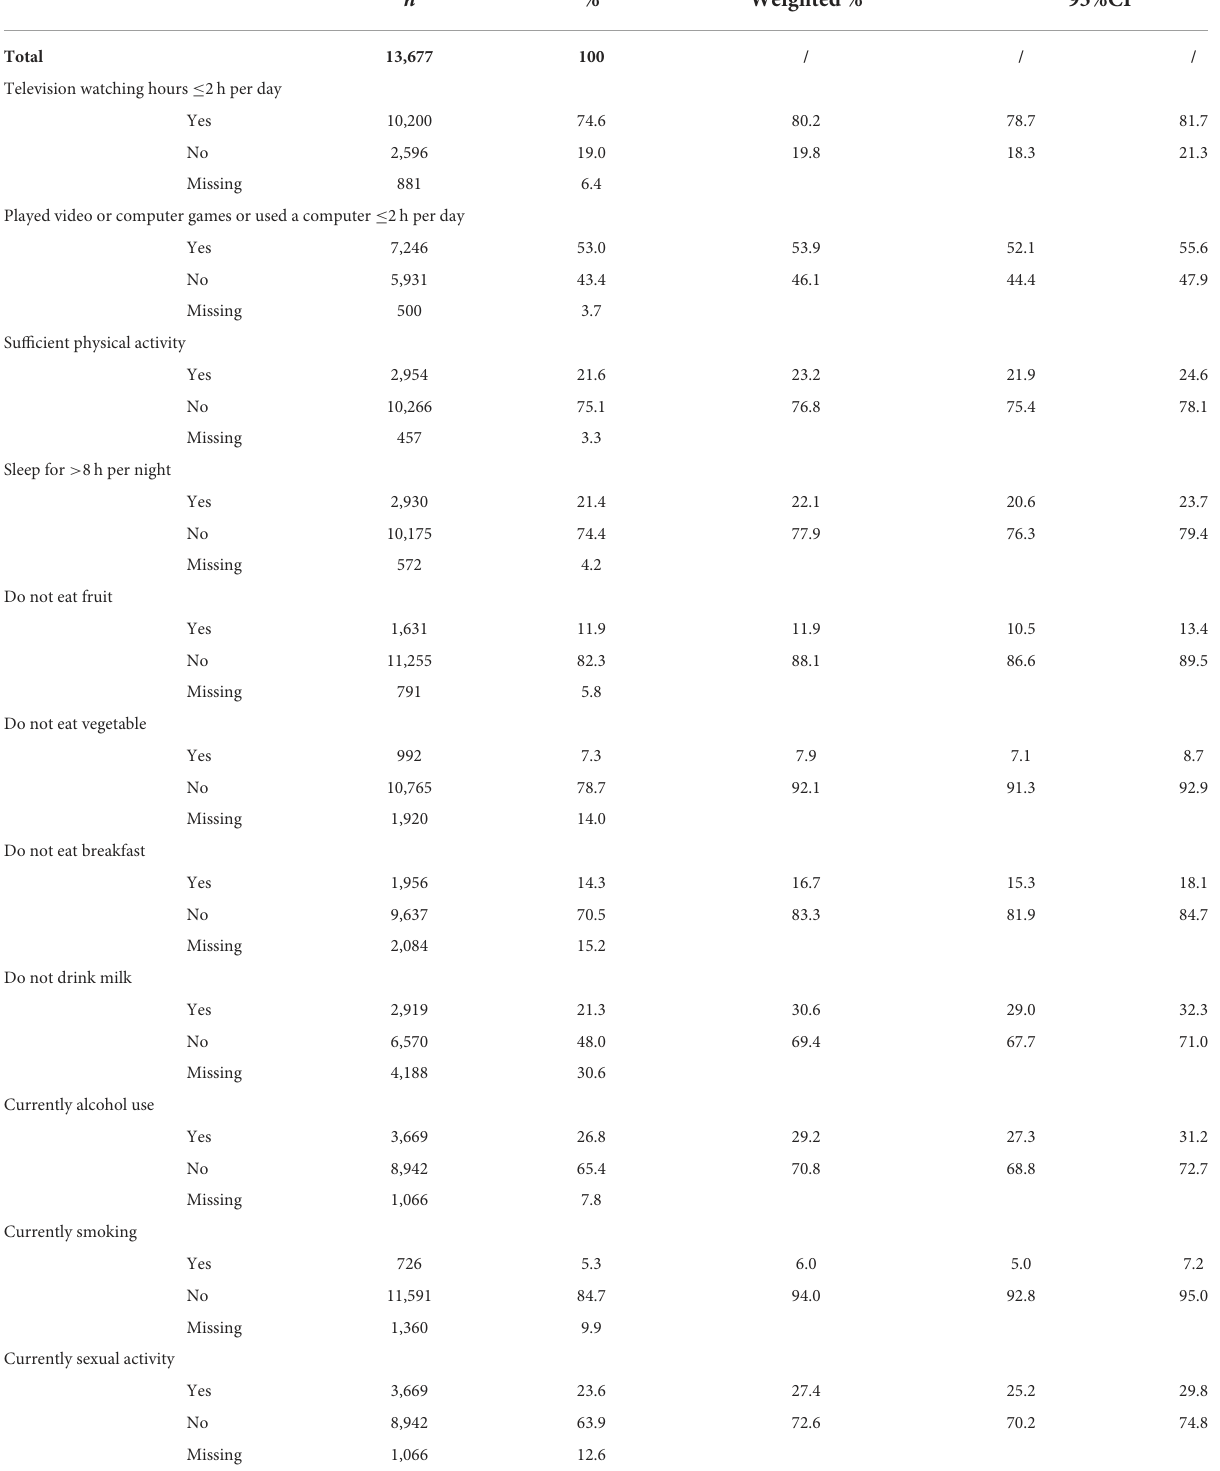
TABLE 2 Prevalence of screen time and lifestyle behaviors. n % Weighted %